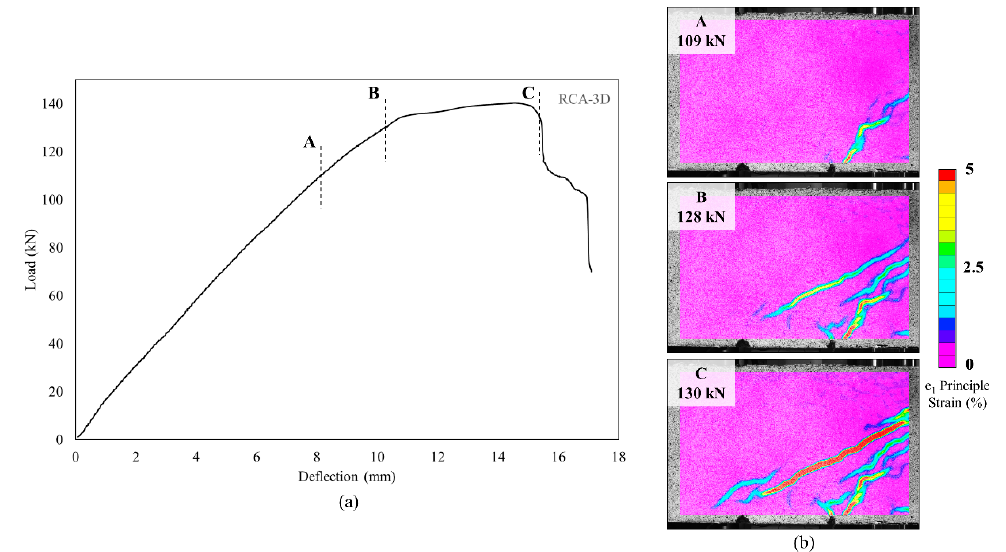
Figure 12. ( a ) A representative load-deflection curve. ( b ) Strain contour plots at different loading levels (A–C).